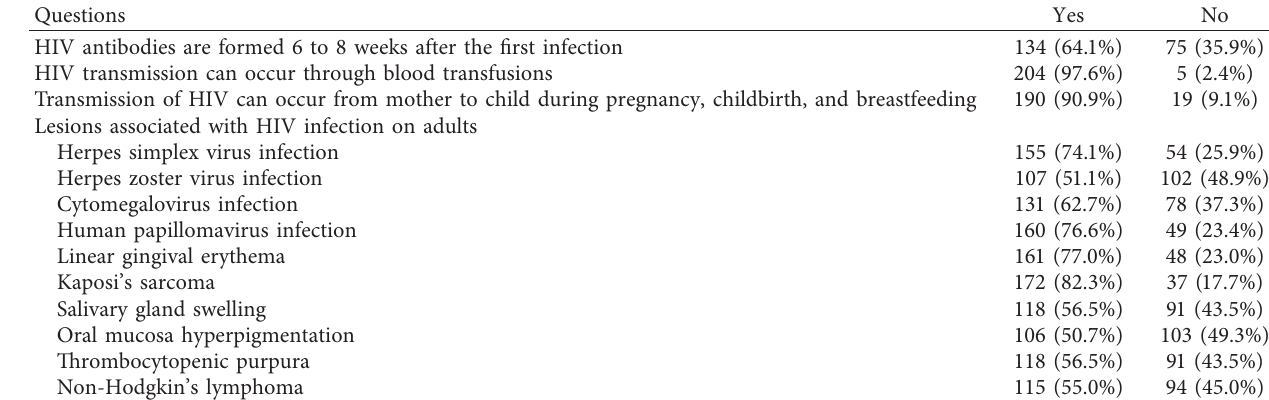
Table 3: Response of dentists to knowledge statements about HIV/AIDS.